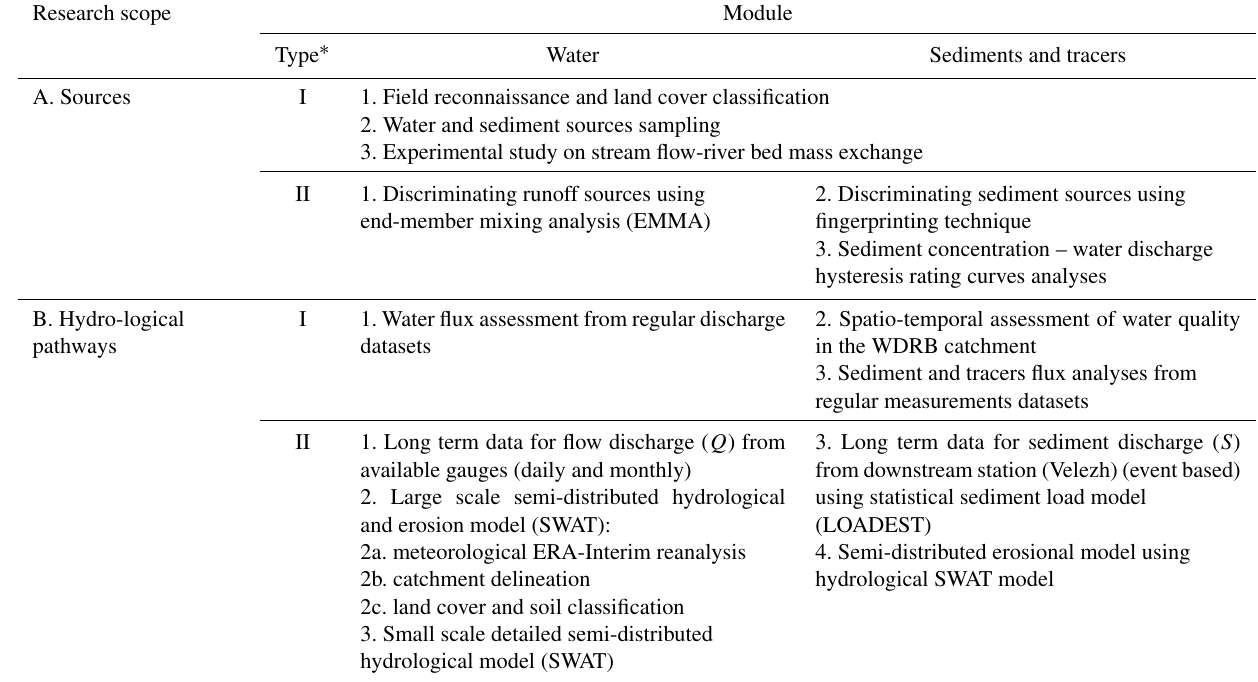
Table 1. Integrated approach to study water and sediment